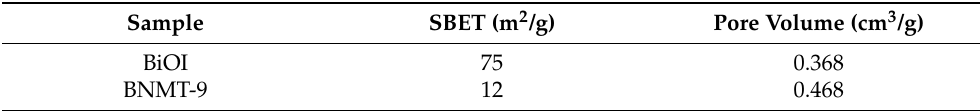
Table 1. The Brunauer, Emmett, and Teller (BET) specific surface area and pore volume of BiOI and